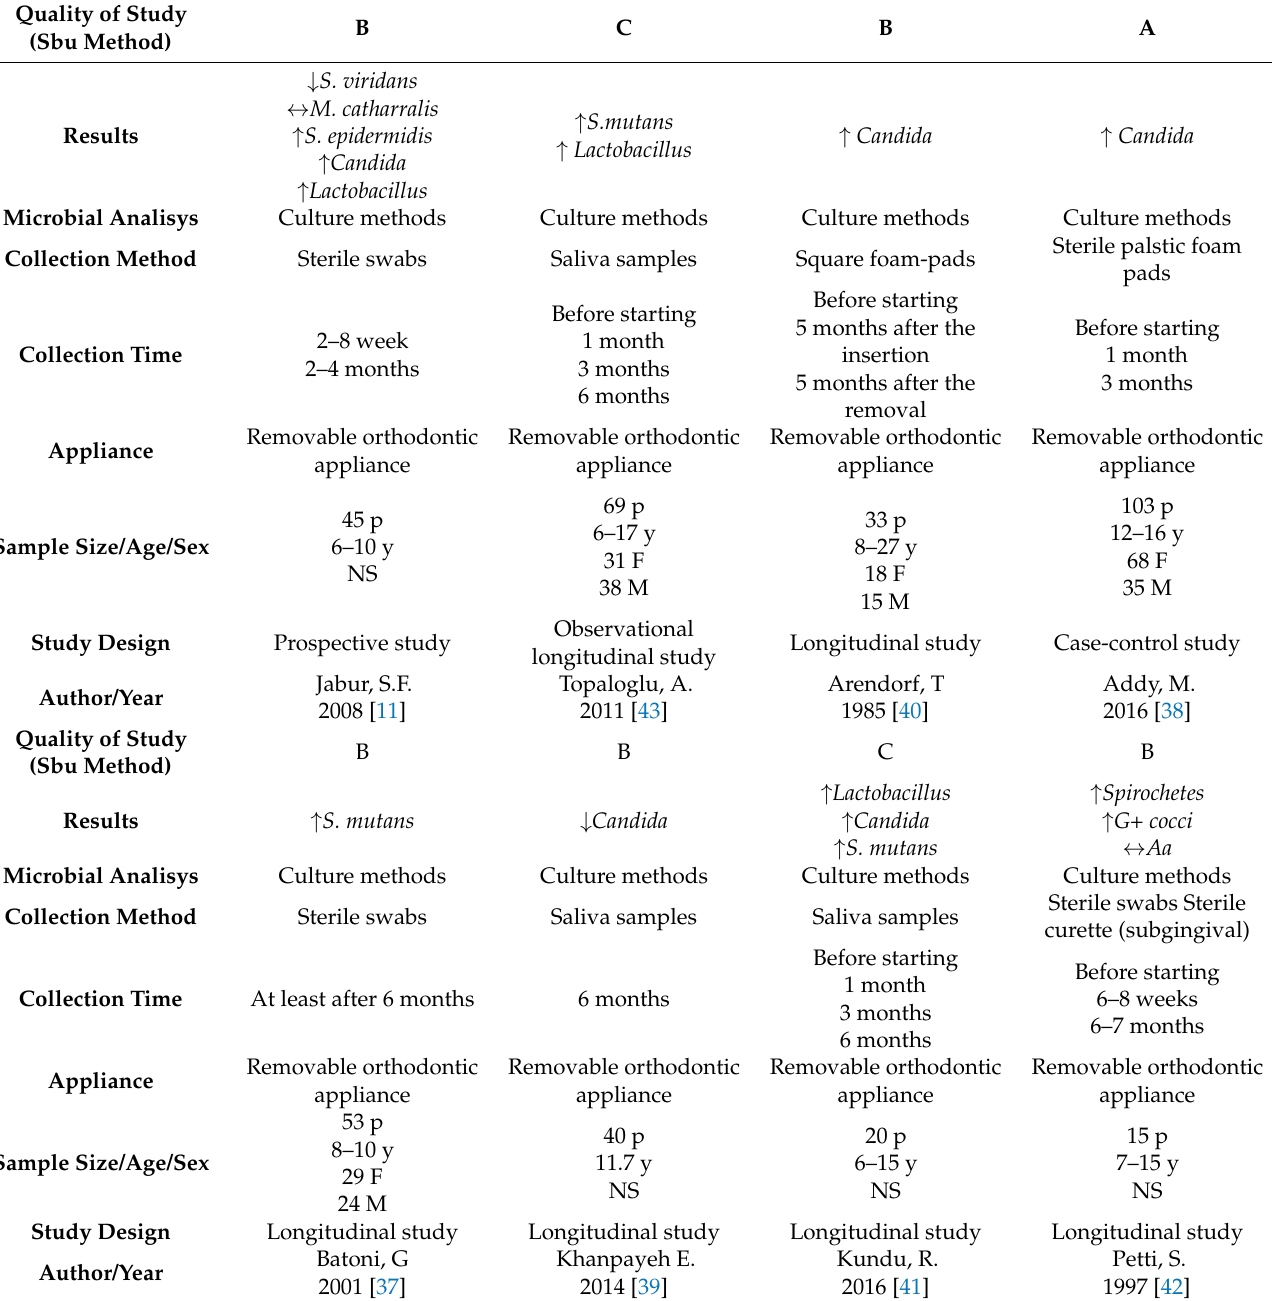
Table 1. Characteristics of the included